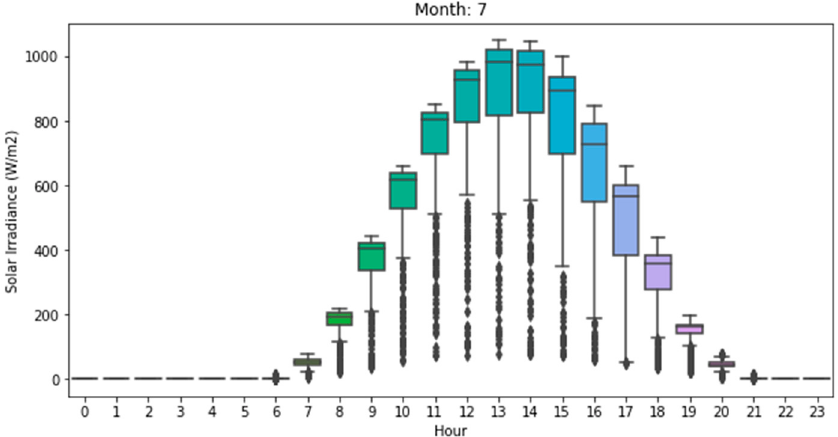
Figure 2. Box-whisker plot of solar irradiance for the days in July from 2005 to 2016. The bold points represent values identified as outliers following Equation (1) with p = 1.5. To each hour is associated a different color of box.